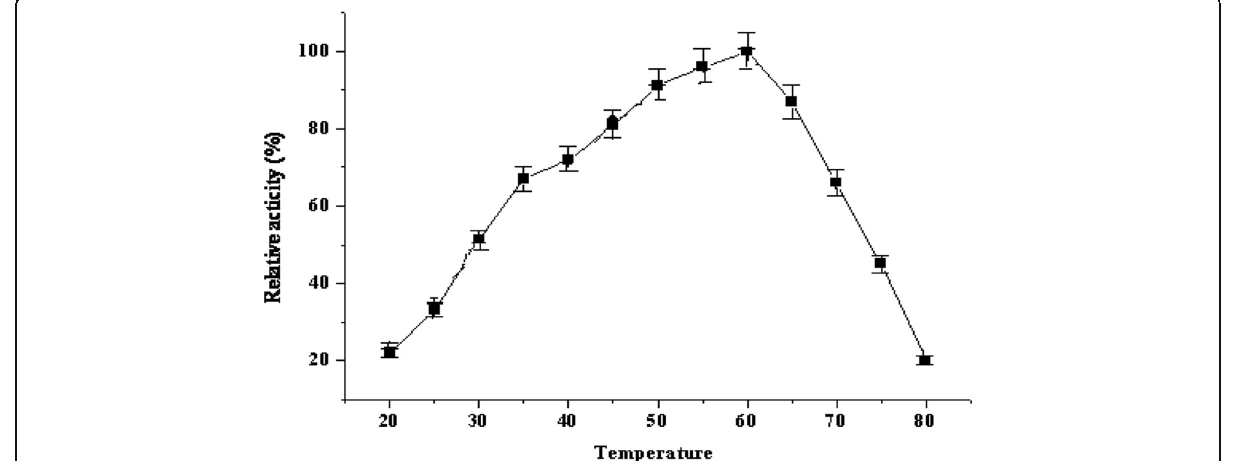
Fig. 5 Effect of temperature on the production of alpha-galactosidase in Penicillium